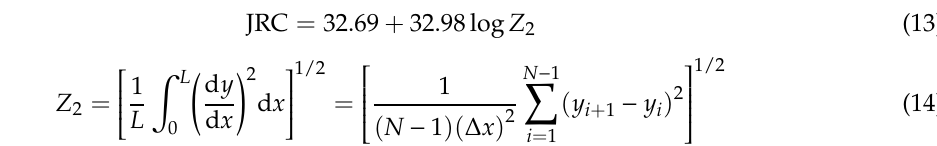
Table 1. Parameters for numerical simulation.